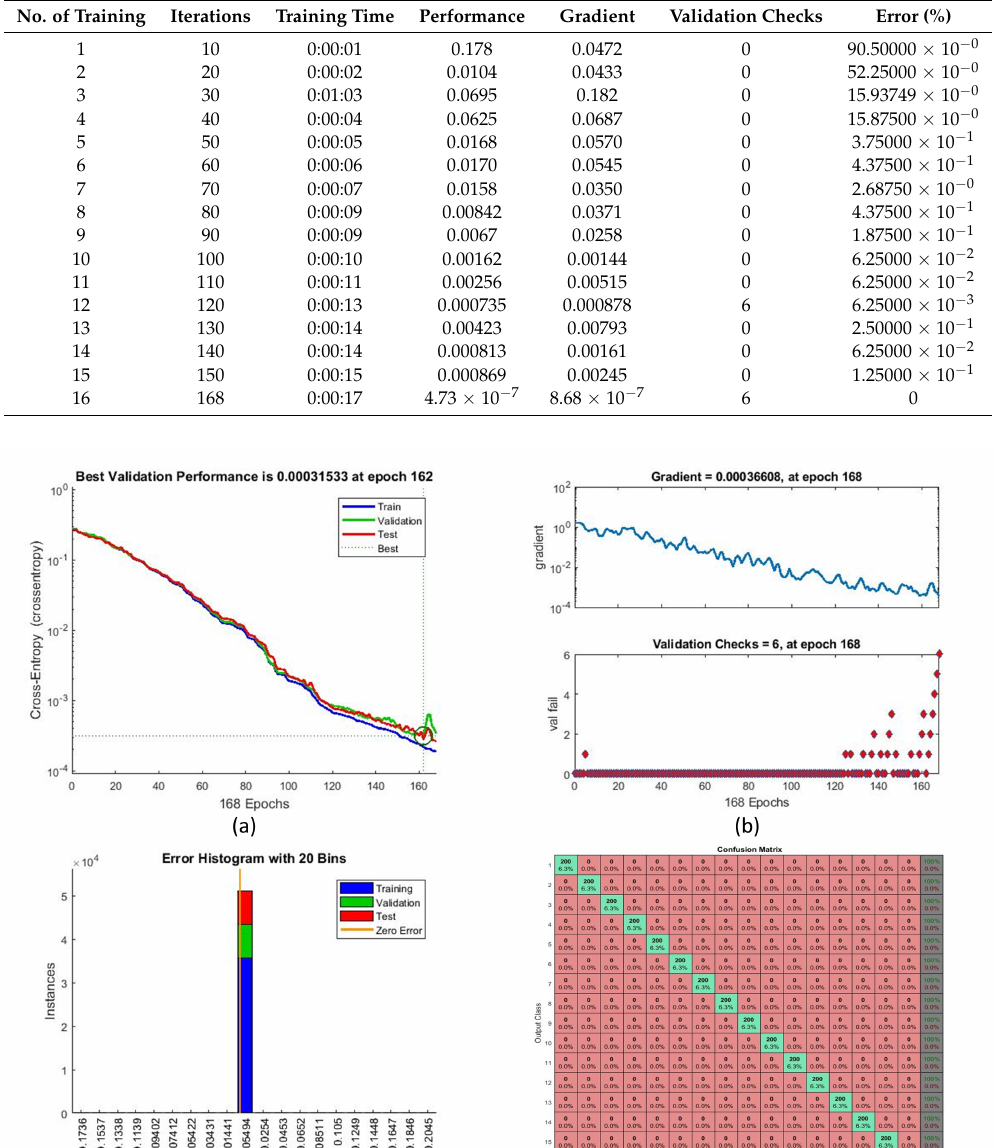
Table 2. Neural network training performance.